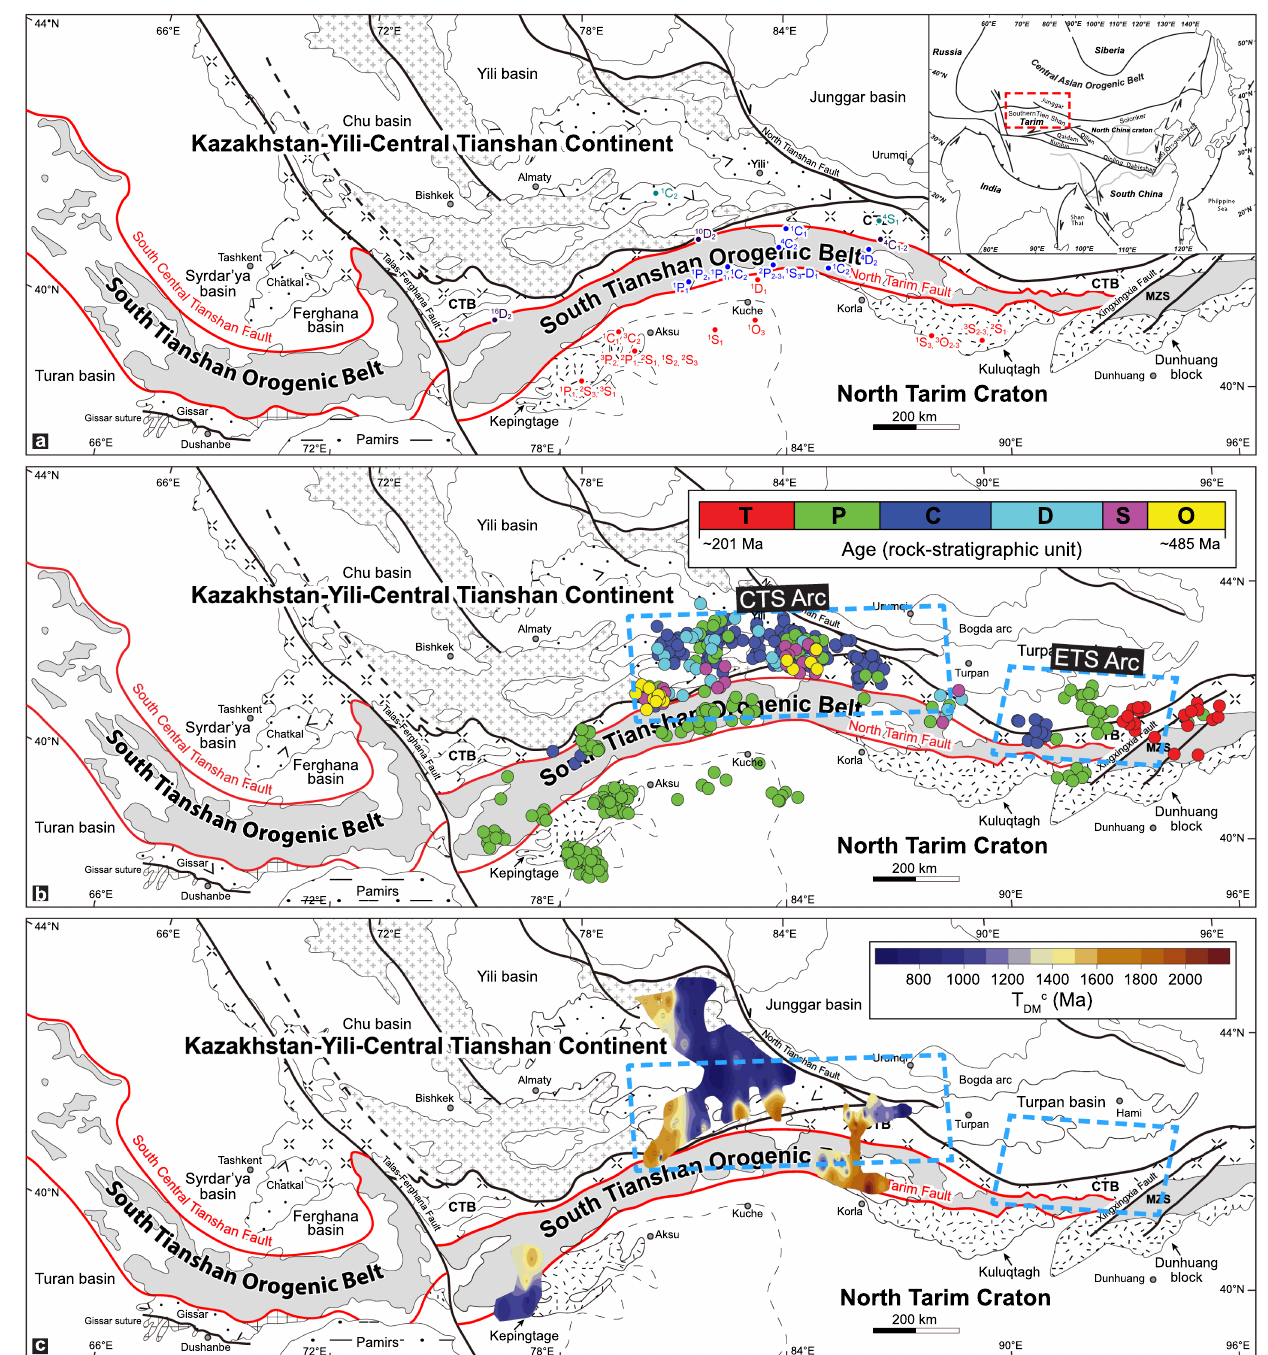
Fig. 5 Geological maps with the highlighted localities of compiled multi-disciplinary data. a collected detrital zircon U-Pb ages of regional sediments (corresponding to data in Table S7), b compiled zircon U-Pb ages of regional intermediate rocks (corresponding to data in Table S6). c Hf isotope contour map after ref. 110 , based on Paleozoic granitoid rocks and felsic volcanic rocks among the STOB, showing the spatial variation of the ancient crustal basement (fragmented craton or micro-continent) with relative old Hf model